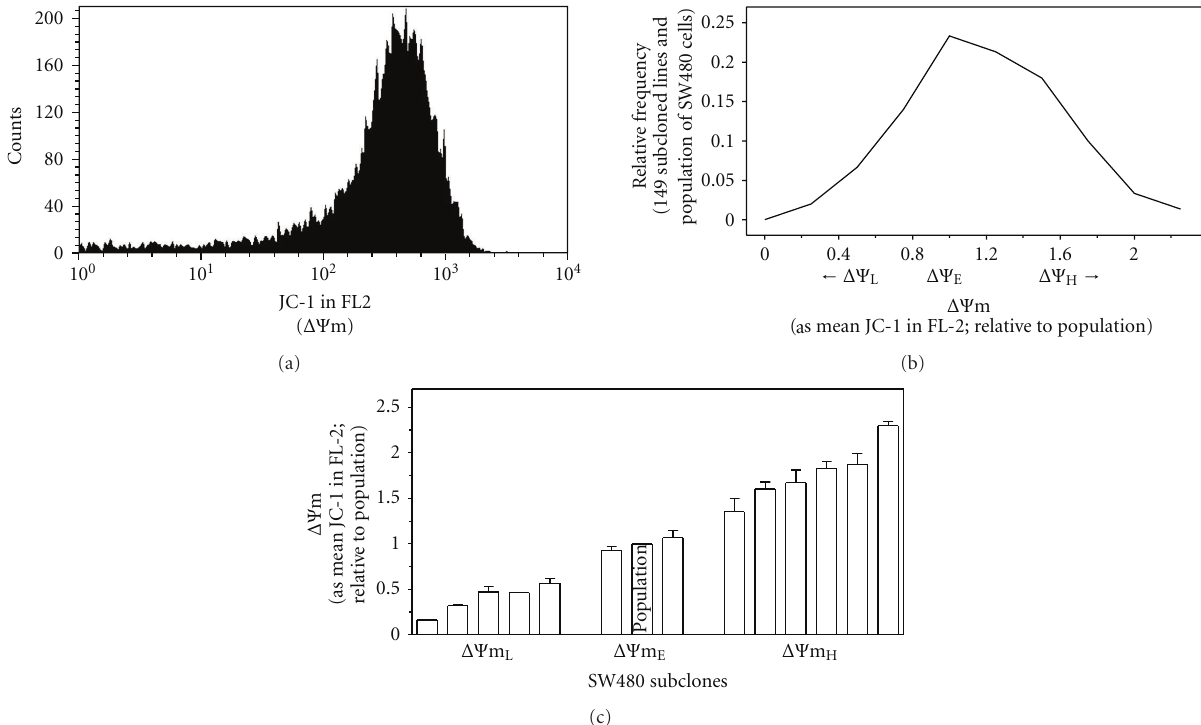
Figure 1: Subpopulations of cells within a primary colonic carcinoma cell population exhibit stable di ff erences in intrinsic ΔΨ m. (a) The SW480 cell line stained with JC-1 and analyzed by flow cytometry in FL-2. (b) The parental population of SW480 and 149 subcloned cell lines were stained with JC-1, analyzed by flow cytometry, the intrinsic ΔΨ m each subcloned line was expressed relative to that of the unselected population of SW480 cells and plotted as a frequency distribution. (c) 13 subcloned cell lines derived from SW480 cells were selected from further study: the intrinsic ΔΨ m of subclones “ ΔΨ m L ” range from 0.17 and 0.50 fold lower; subclones “ ΔΨ m E ” equivalent; and subclones “ ΔΨ m H ” from 1.60 to 2.30 fold higher than that of the population of SW480 cells (also see Figure 1(b)). Mean and SEM of multiple ΔΨ m determinations made over approximately 1 year. The intrinsic ΔΨ m of all of the ΔΨ m L subclones are statistically di ff erent from all of the P ≤ 0 . ΔΨ m H subclones (Bonferroni’s Multiple Comparison Test;